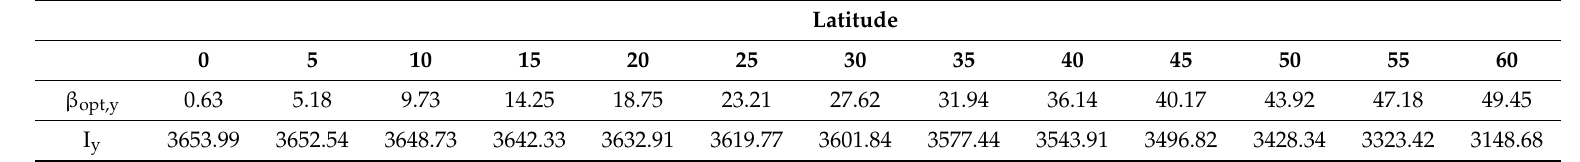
Table 12. The annual optimum tilt angle β opt,y, and extraterrestrial radiation I y in kWh / m 2 for a di ff erent